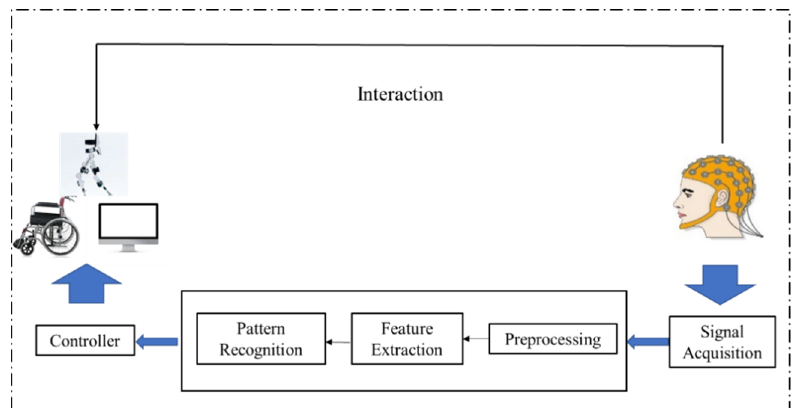
Figure 1. Framework of an electroencephalography (EEG)-based brain–computer interface (BCI) Figure1. system.